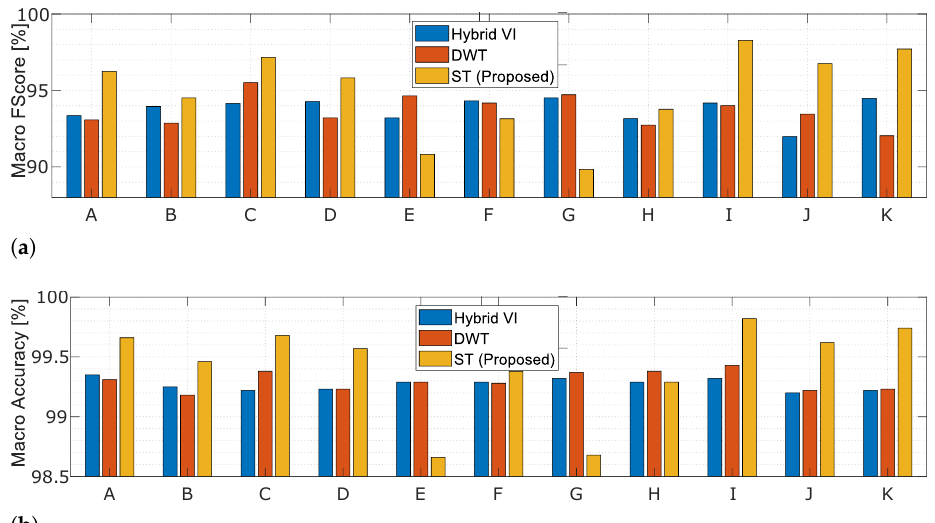
Figure 7. Best accuracies and FScores for each scenario with subset LIT-SYN-8. ( a ) FScores for each scenario with ENS Classifier. ( b ) Accuracies with ENS Classifier.